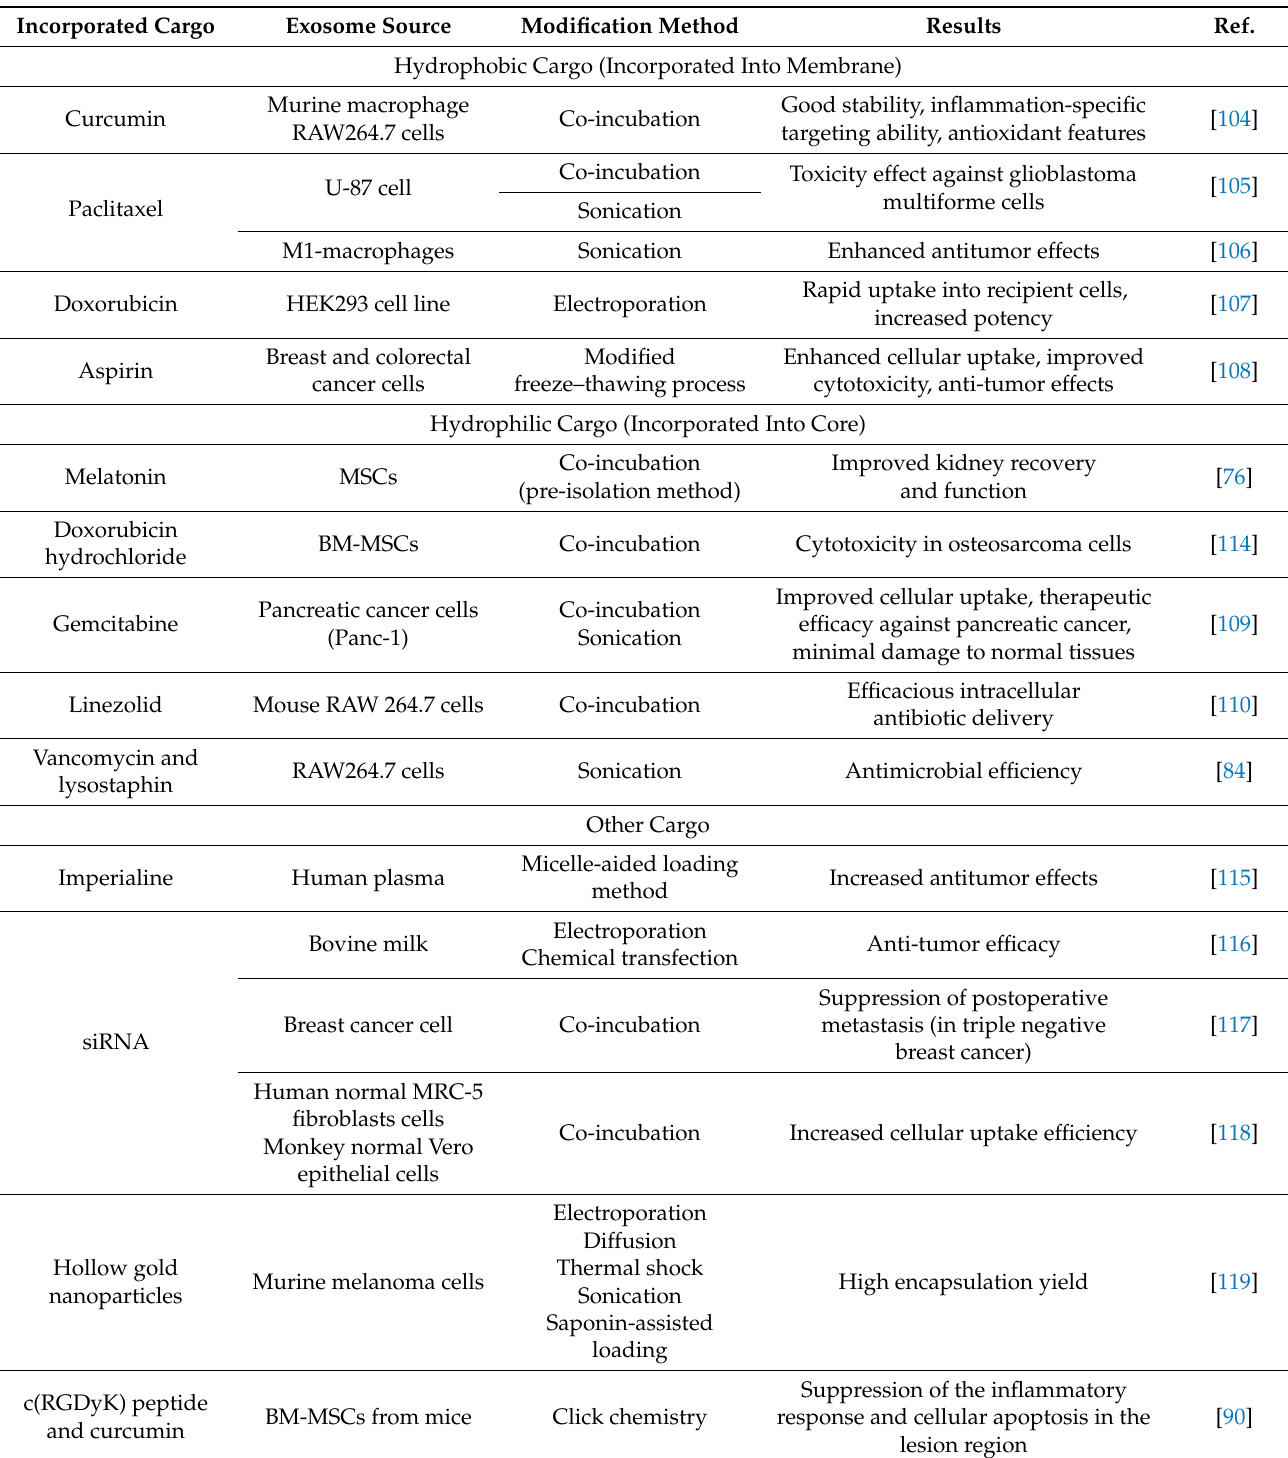
Table 2. Examples of different types of cargo incorporated into naturally derived exosomes through modification